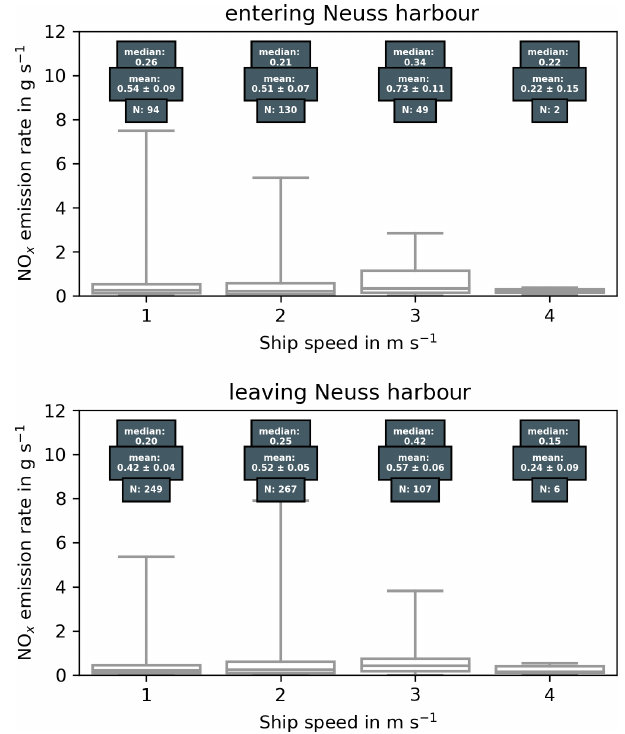
Figure 12. NO x emission rates for ship class IV and their depen- dence on the direction of travel and ship speed over ground, as de- rived from data measured at